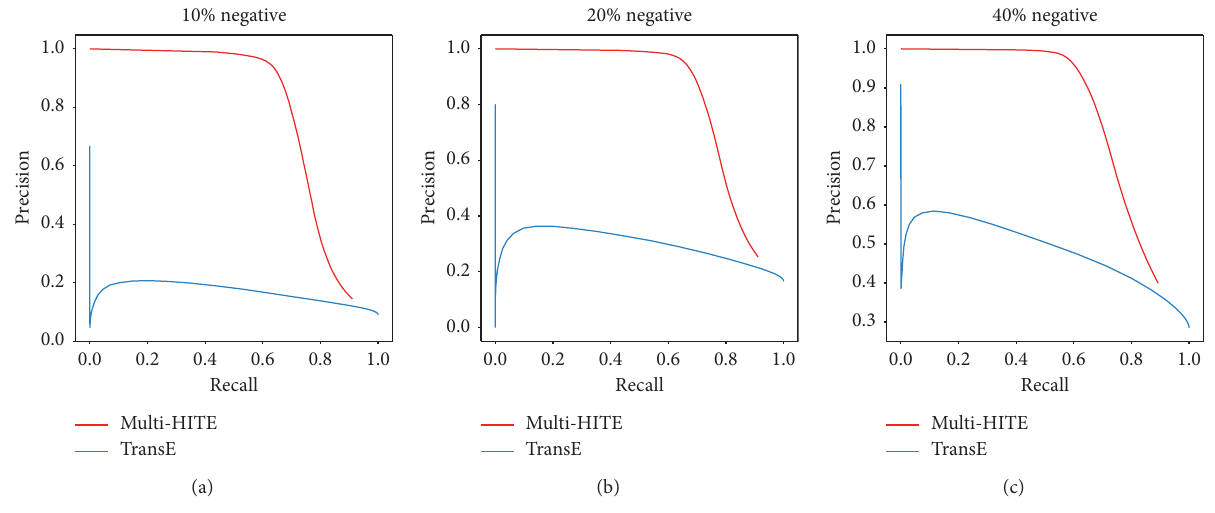
Figure 4: Trade-off between precision and recall according to trustworthiness threshold.